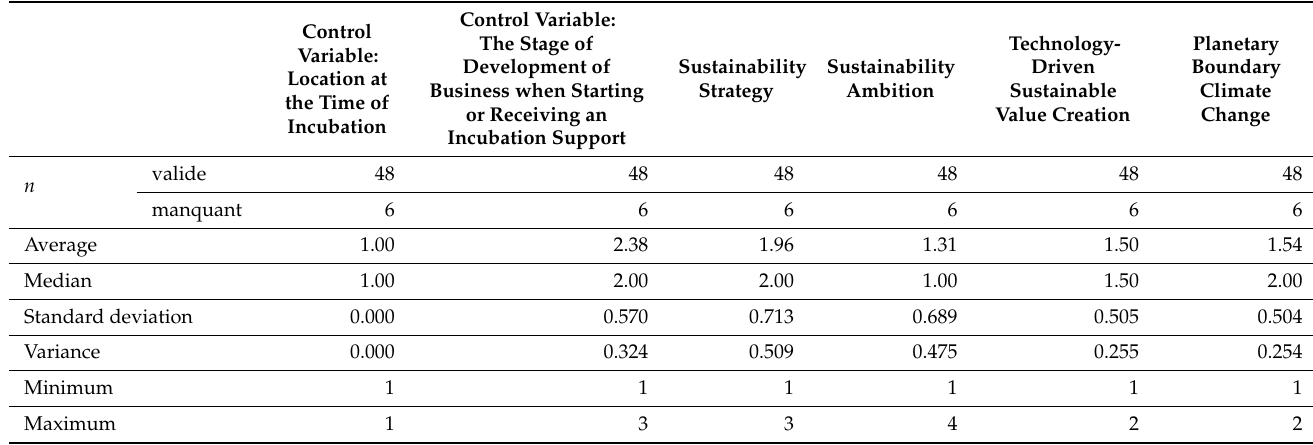
Table A5. Table of the Descriptive Statistics.